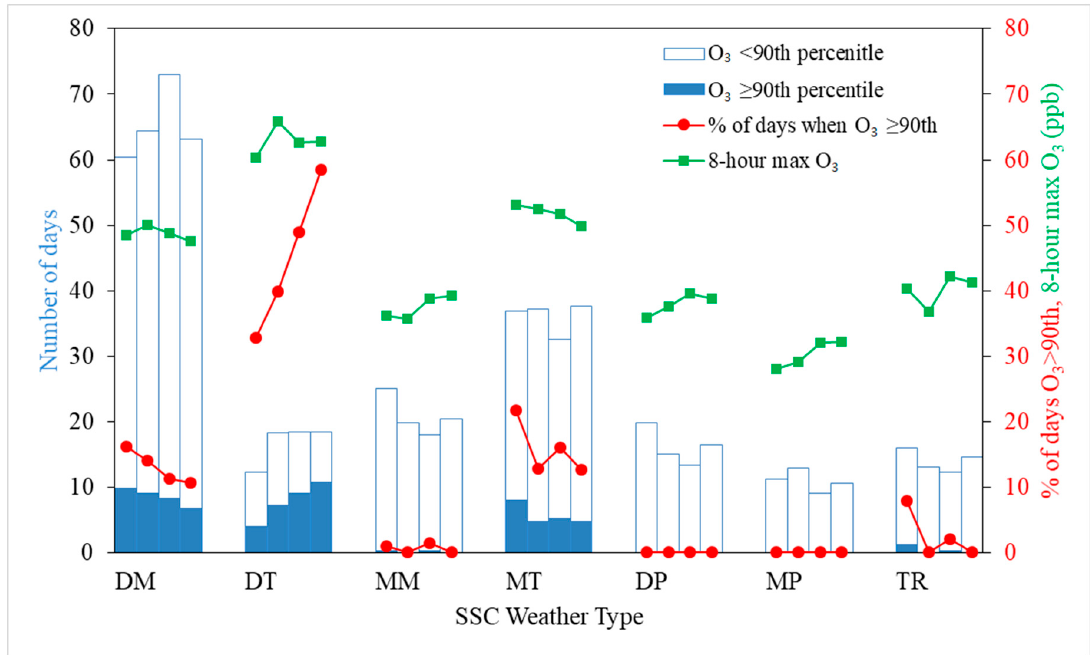
Figure 5. Occurrence frequency of different spatial synoptic classification (SSC) weather types and 8 h max O 3 in Windsor in smog season during 1996–2015. DM (dry moderate), DT (dry tropical), MM (moist moderate), MT (moist tropical), DP (dry polar), MP (moist polar), and TR (transitional). Each bar or point represents a period of 5-year.